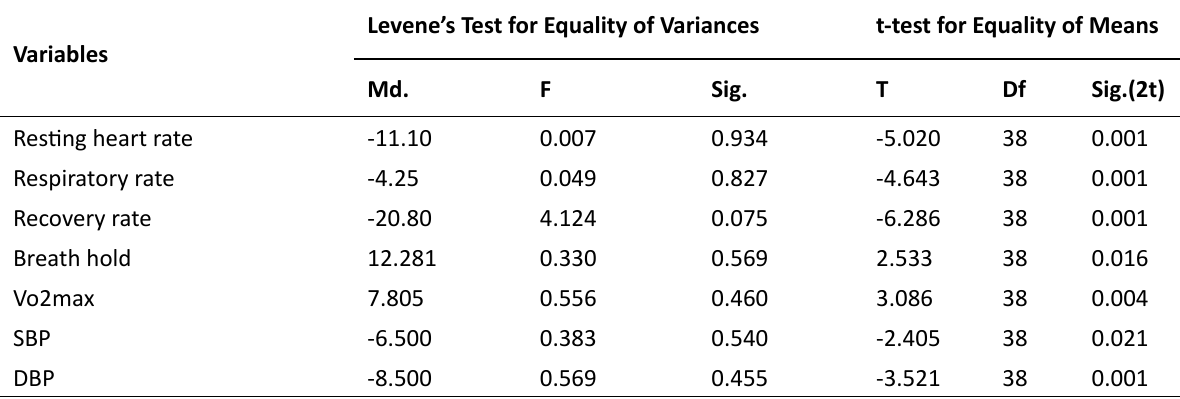
Table 3. Changes in outcome between the intervention group doing Low-intensity interval training and the control group within 8 weeks of